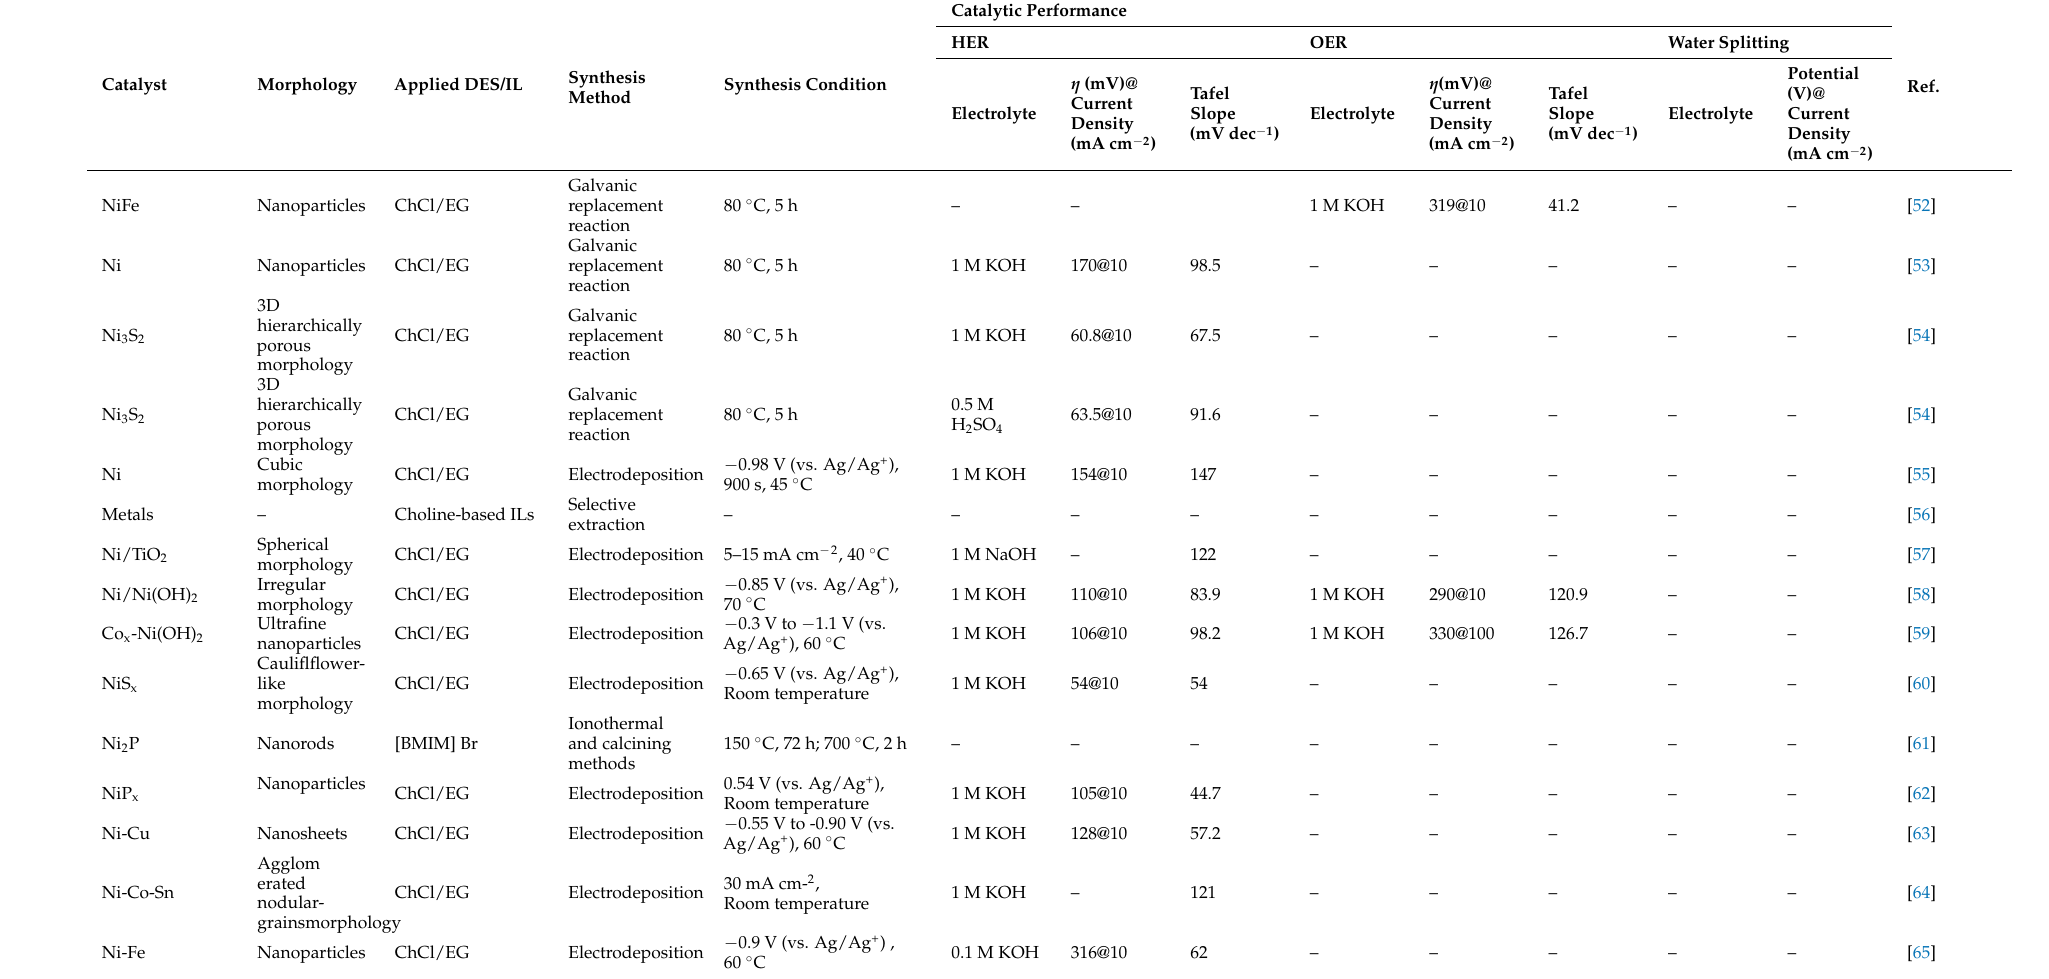
Table 2. Summary of HER, OER and Water Splitting Performance of Catalysts Involved in the Section